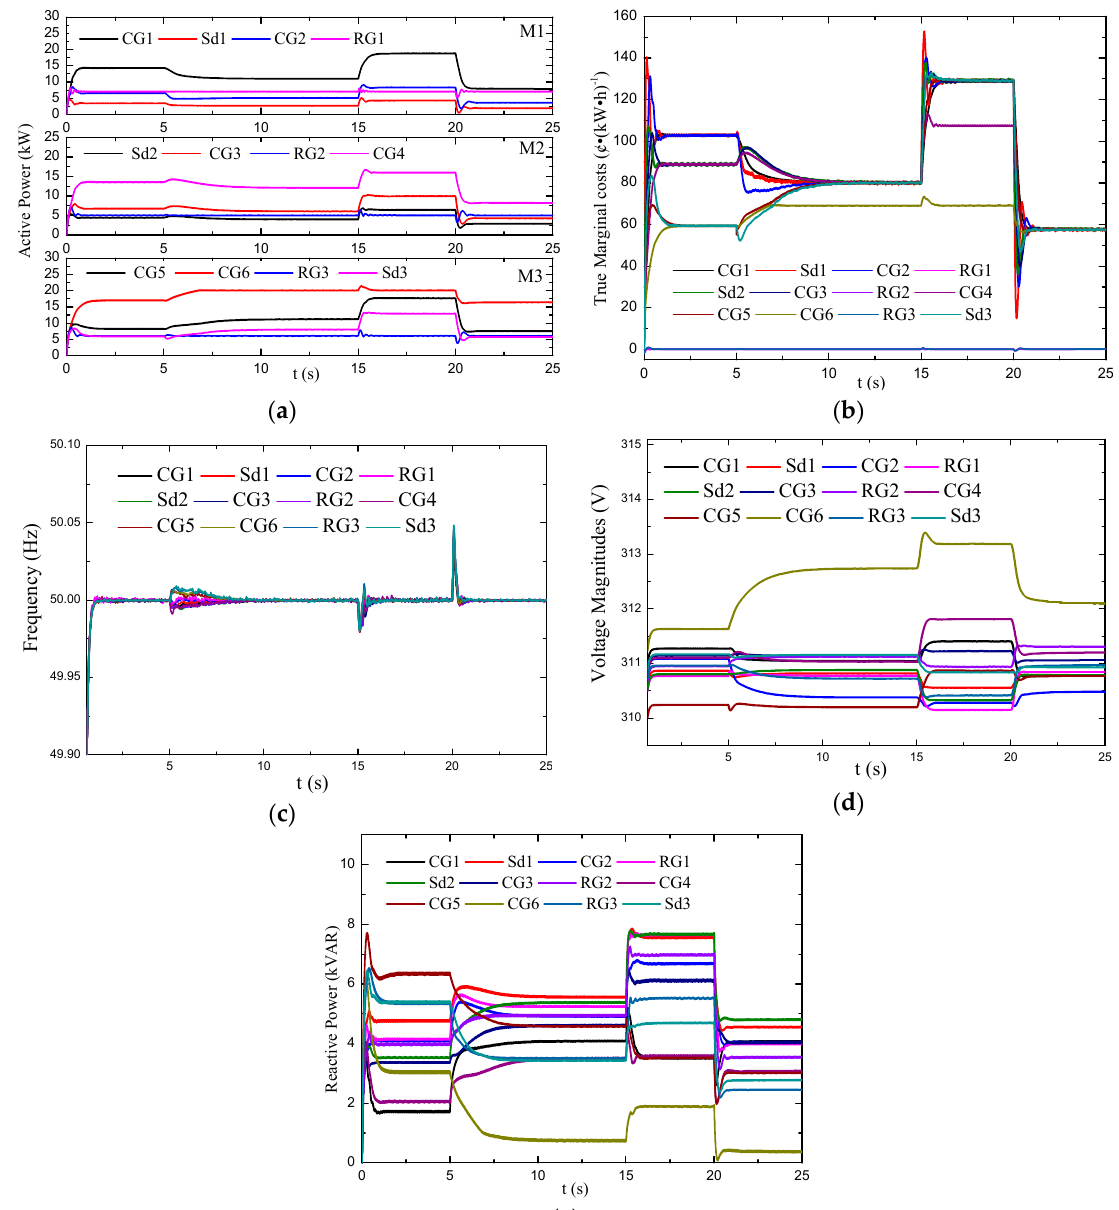
Figure 4. The operating performance in MGC: ( a ) Active power outputs of DERs; ( b ) The true marginal costs of DERs; ( c ) The system frequency; ( d ) The voltage magnitudes; ( e ) Reactive power outputs of